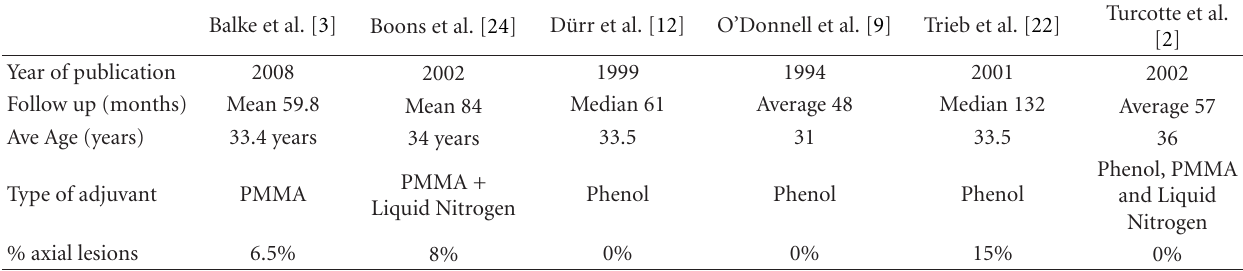
Table 1: Characteristics of included studies.